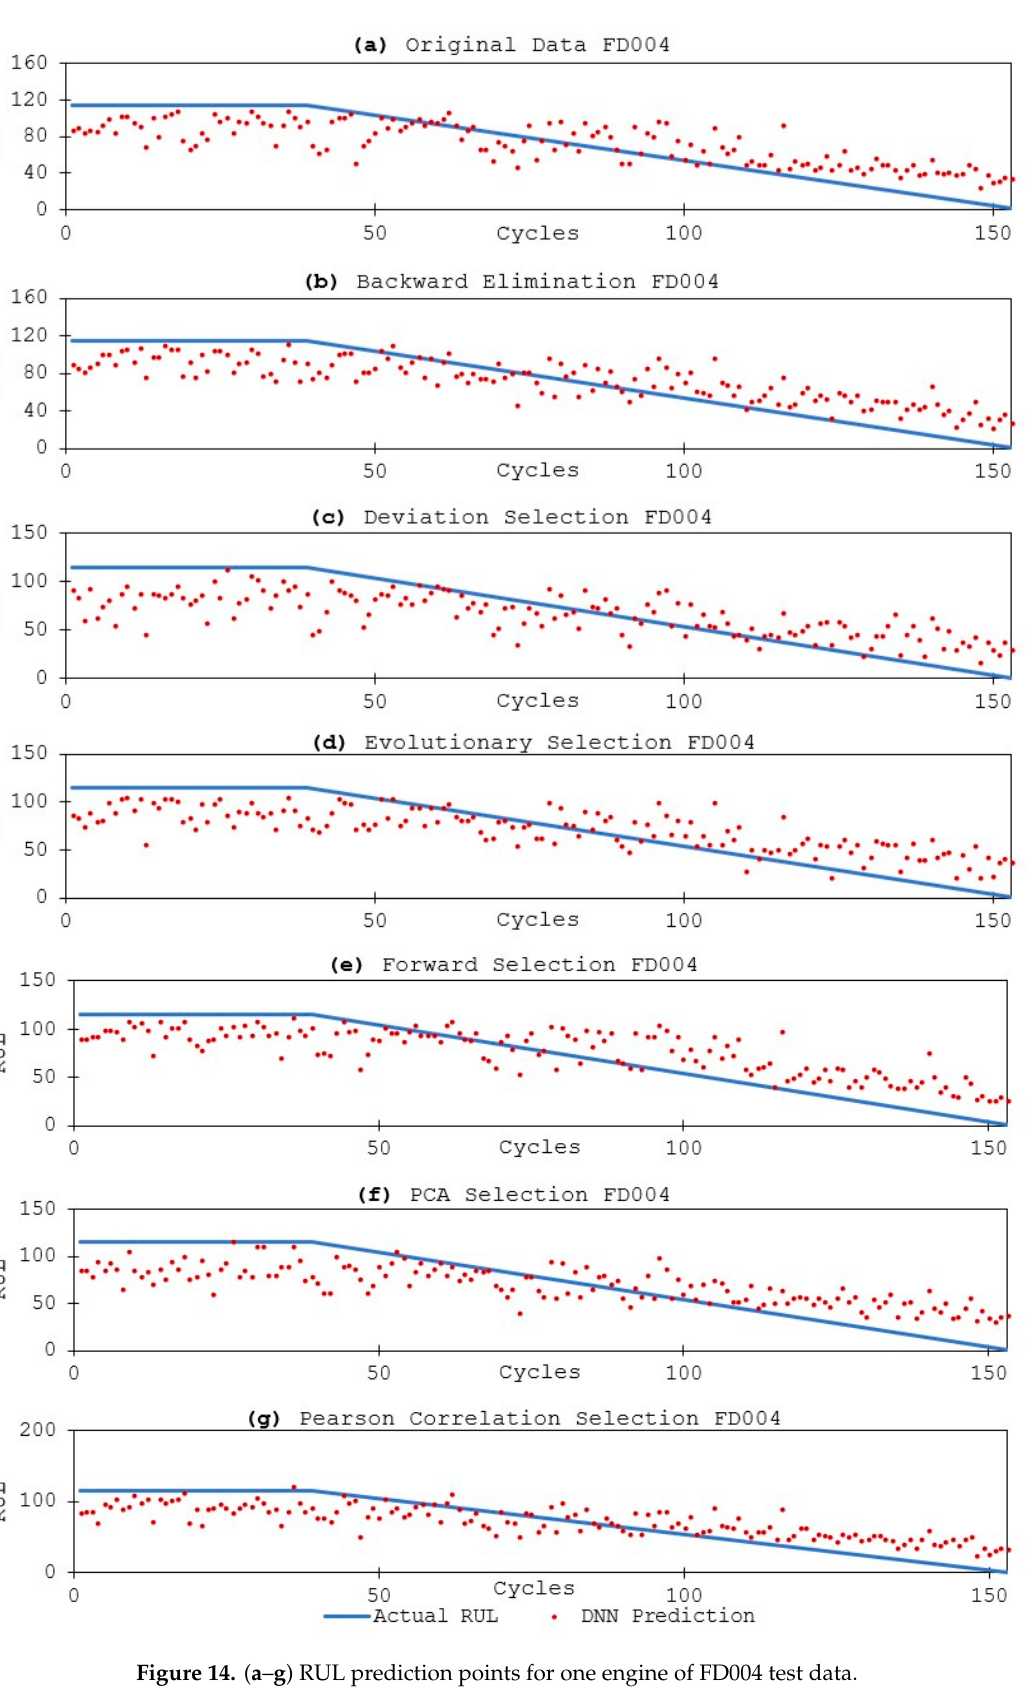
Figure 14. ( a – g ) RUL prediction points for one engine of FD004 test data.